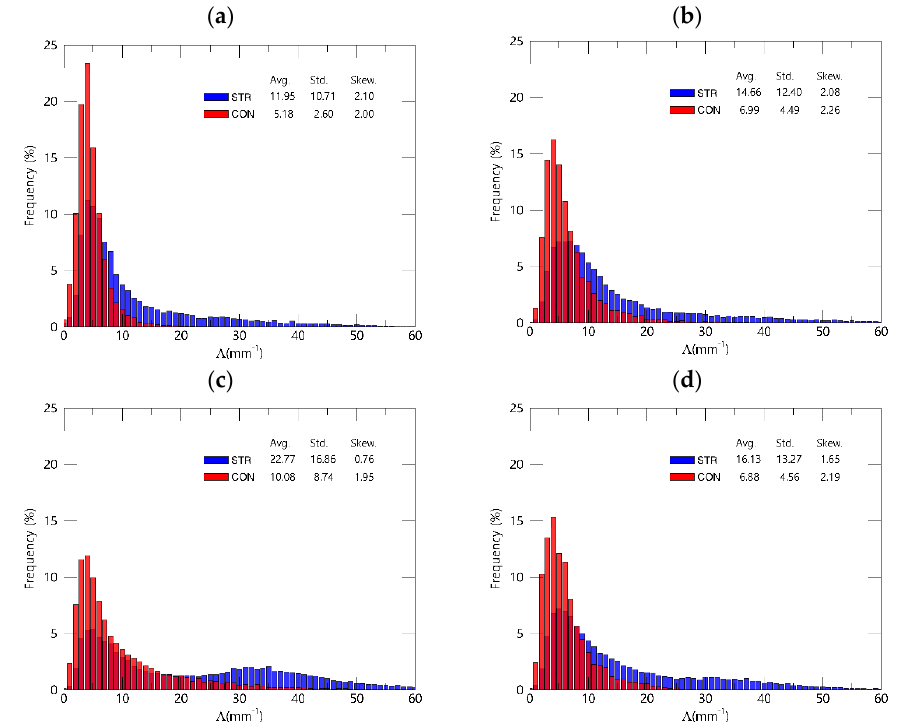
Figure 9. The occurrence frequency of slope parameters with rain type at ( a ) BOS, ( b ) BUS, ( c ) CPO, and ( d ) JIN site. The blue represents stratiform rain and the red represents convective rain. The legend shows the average (Avg.), standard deviation (Std.), and skewness (Skew) of slope parameter.